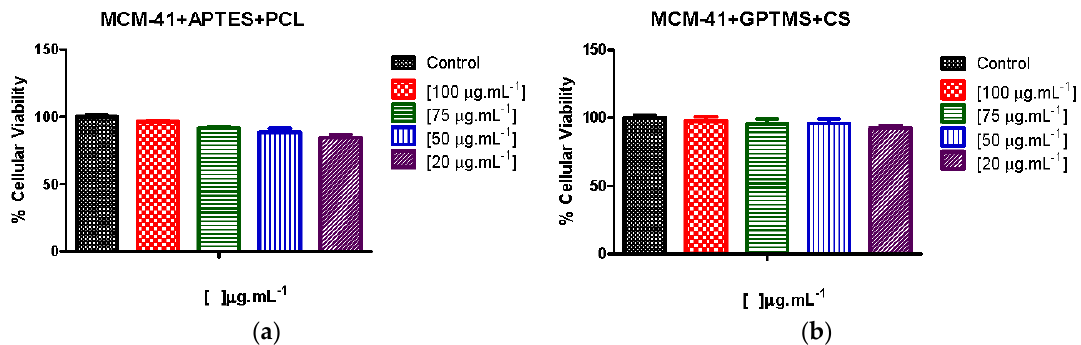
Figure 6. The MTT assays in vitro of cytotoxicity and biocompatibility of different nanoparticles. ( a ) MCM-41 + APTES + PCL; ( b ) MCM-41 + GPTMS + CS.